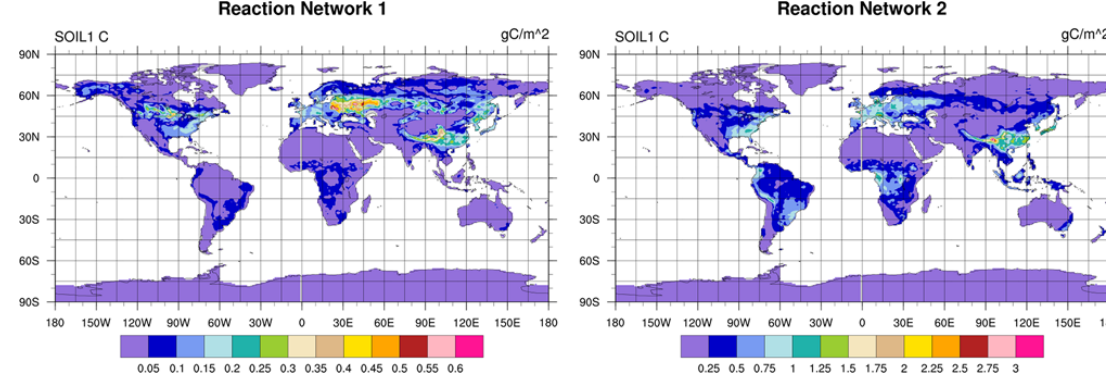
Fig. 5. Spatial distribution of C in soil1 pool using Reaction Network 1 (left) and Reaction Network 2